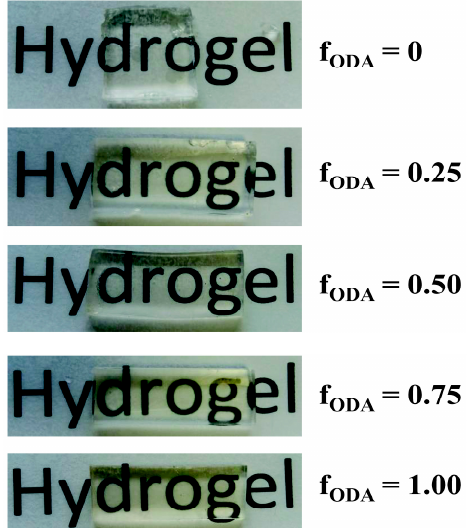
Figure 4. Images of hydrogel samples placed over the label “hydrogel”. Samples equilibrated in 0.1 M NaCl (thickness ca. 3 mm).